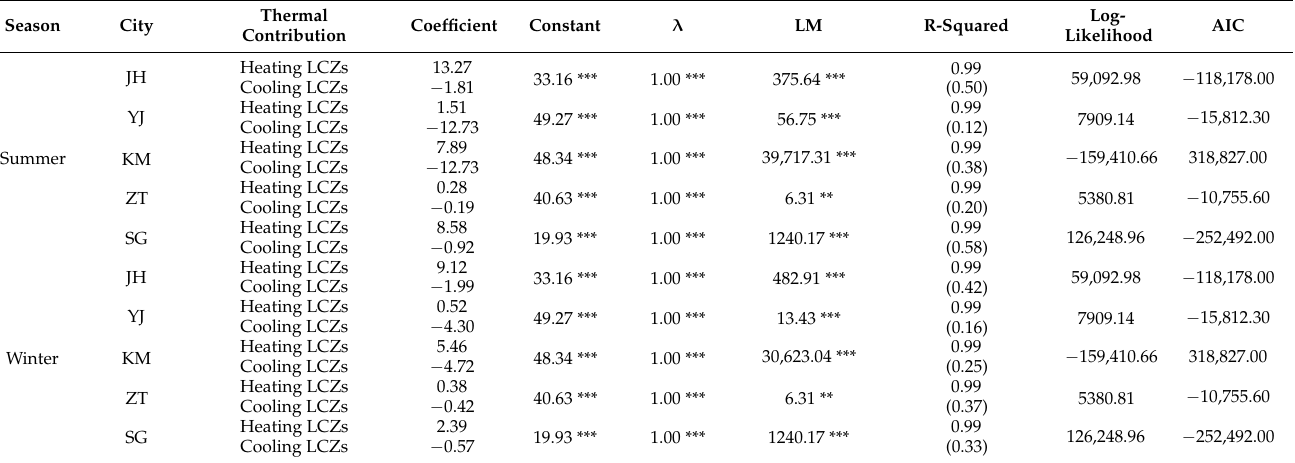
Table A3. The results of SEM (*** p < 0.001, ** p < 0.01, R-squared values of OLS are presented in parentheses).